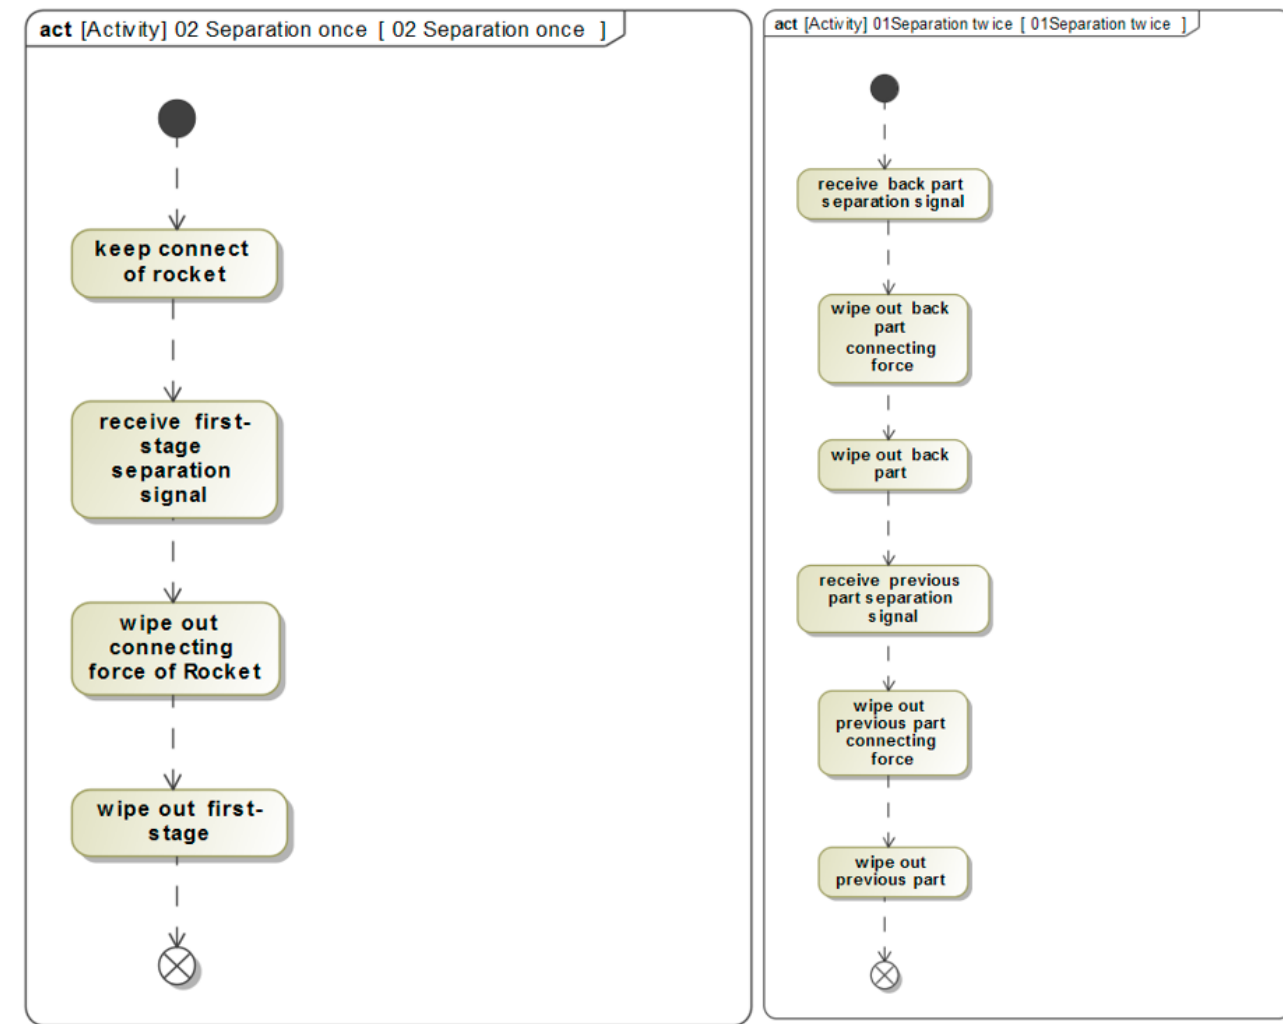
Figure 6. Two alternatives of separation once and separation twice.